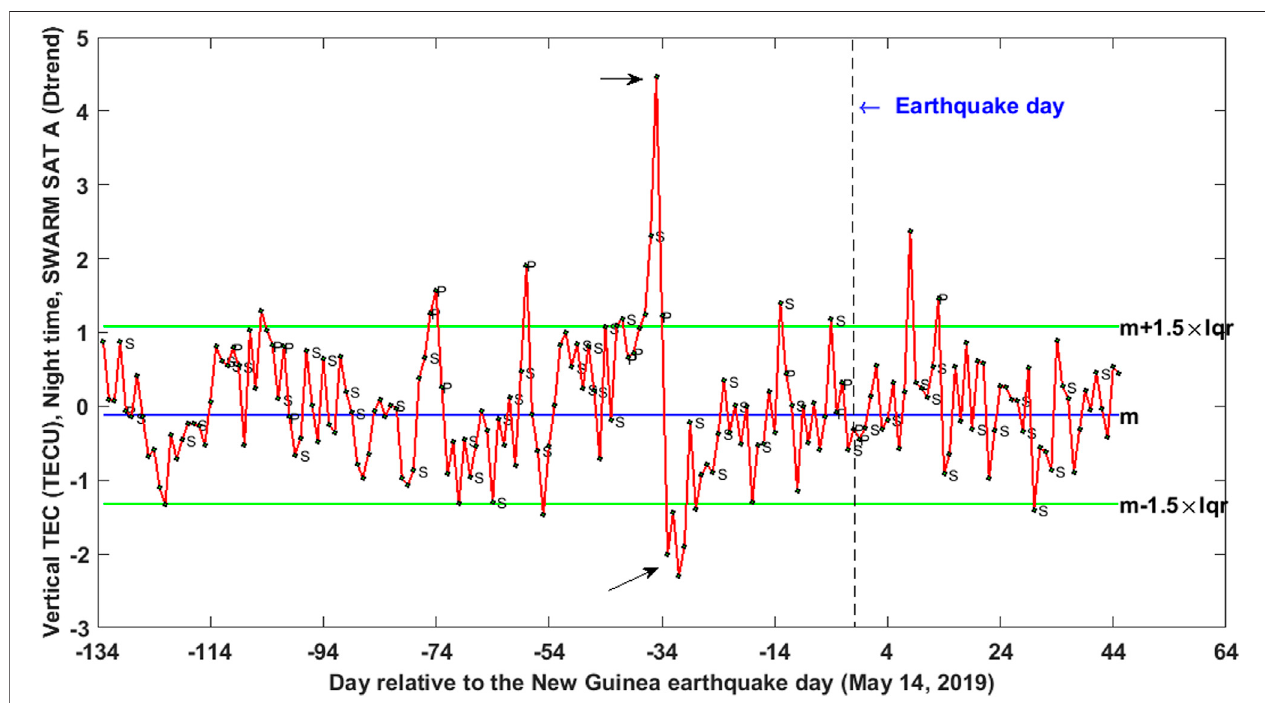
FIGURE 4 | Results ofSwarm A night time VTEC data analysis for the Papua New Guinea (May 14, 2019) from January 01 toJune 30, 2019. The symbols “ P ” and “ S ” indicate disturbed magnetic days ( “ P ” according to magnetic indices, “ S ” according to solar parameters).